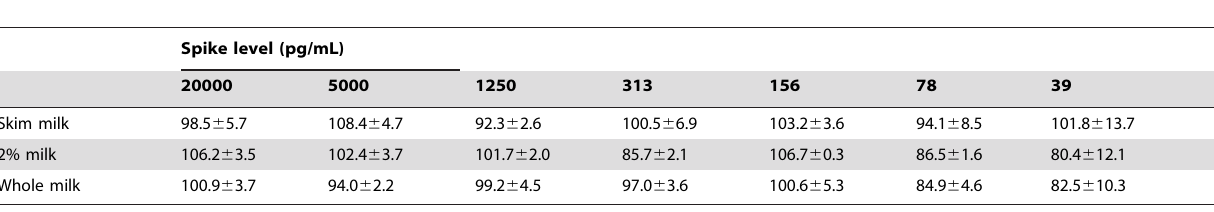
Data are presented as averages of three independent experiments, 6 1 standard error.